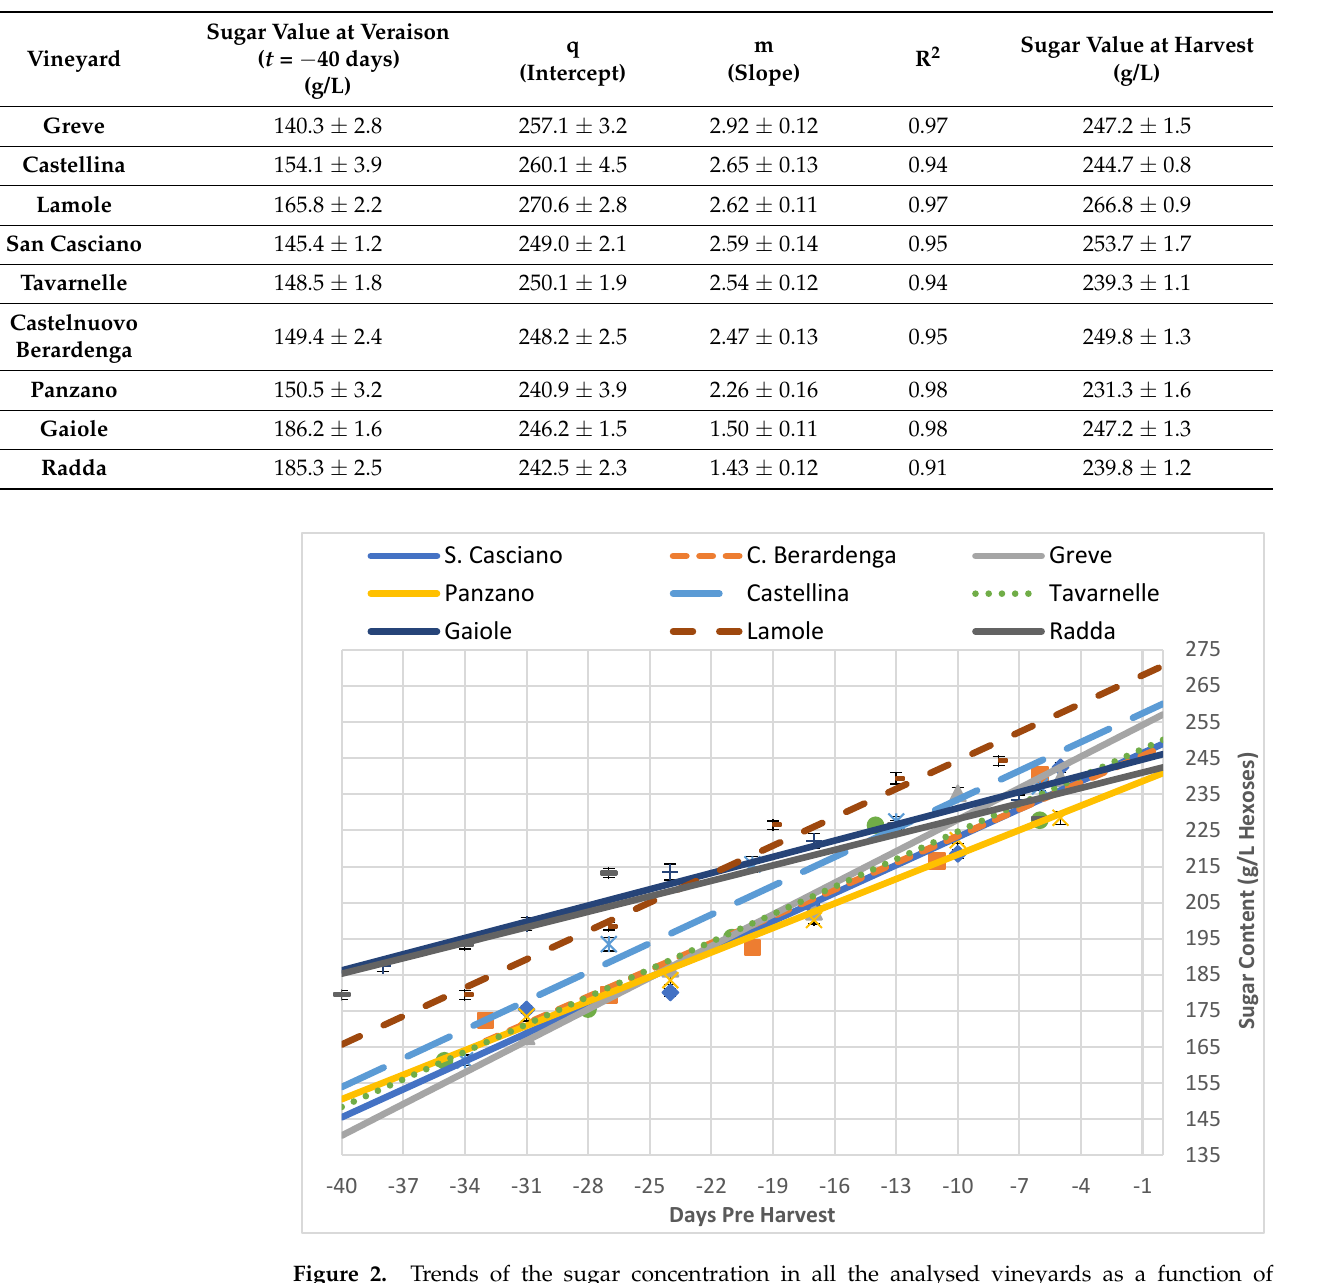
Figure 2. Trends of the sugar concentration in all the analysed vineyards as a function of time (expressed as negative days before the harvest). Each analytical point is reported with its 68% C.L. interval.